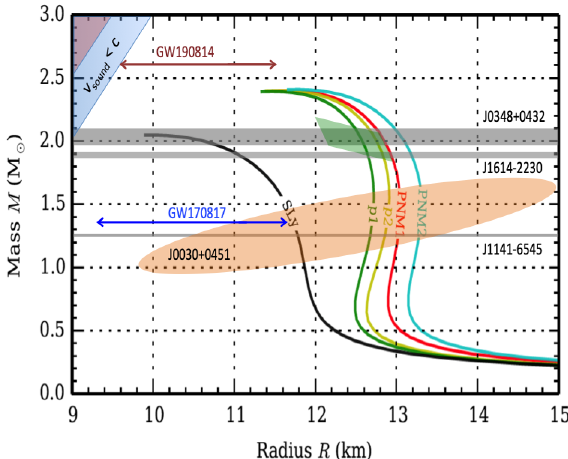
Figure 3: (Color online). The mass-radius relation for pure neutron matter (PNM1 and PNM2) and with an admixture of 10% protons (p1 and p2) for K 0 = 245 and 260 MeV re- spectively. The calculations based on assumption that nu- clear force is being mediated by a 17 MeV boson.